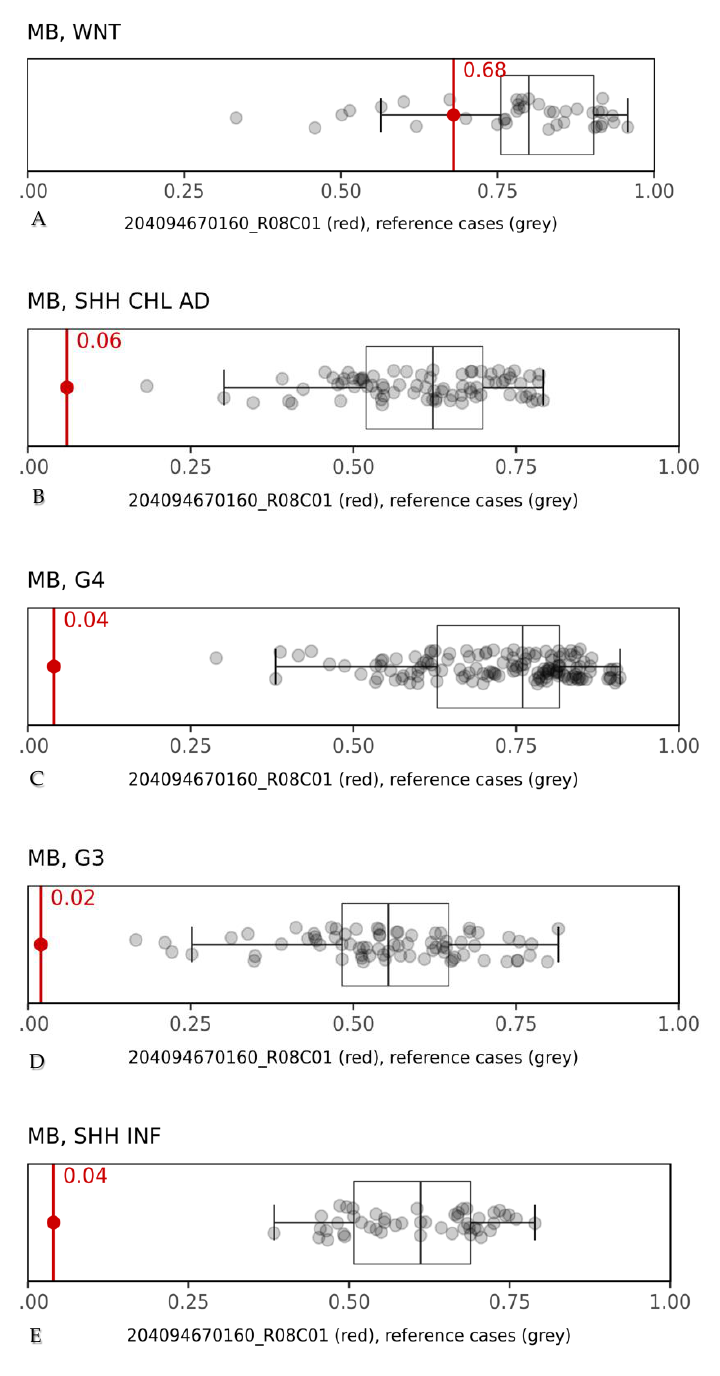
Figure 3. Box-and-whisker plots depicting the maximum raw classification scores (0.68) of the tumor sample in the methylation class “medulloblastoma, WNT” ( A ). Grey dots represent the reference cases in the various methylation class ( B – E ). MB: medulloblastoma.